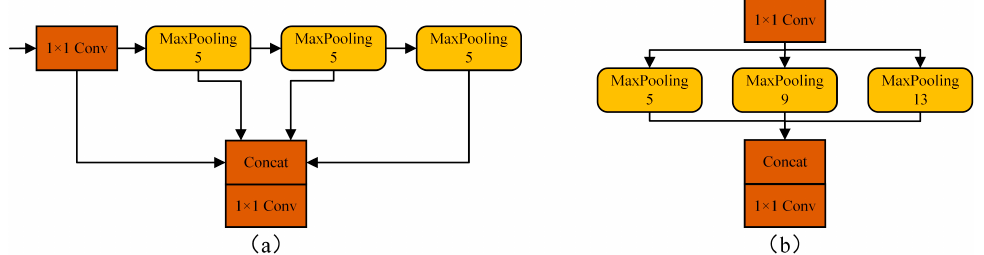
Figure 5. Muti-sensory filed fusion structure. ( a ) SPPF serial pooling structure; ( b ) SPP parallel pooling structure.